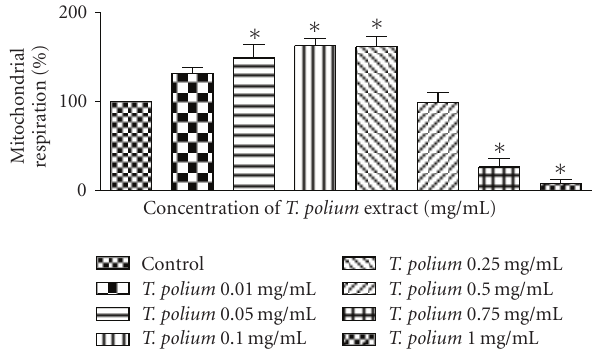
Figure 1: E ff ect of increasing concentrations of an aqueous extract of T. polium on mitochondrial respiration in HepG2 cultured cells using the MTT assay. Data are presented as mean ± standard devi- ation. Sample size ( n ) = 9. ∗ p < 0 . 01 represents the significance of the di ff erence from the control. All data are depicted as a percentage with respect to control (100% mitochondrial respiration).